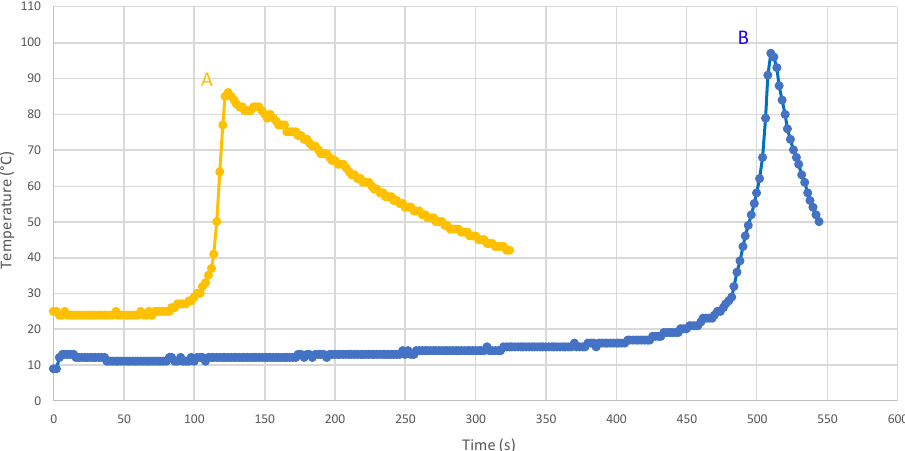
Figure 8. Optical pyrometric measurements (temperature vs. time after mixing; 4 mm thick sample) under air for the BM resin for Redox FRP using a T4epa/Iod (1.5%/1% w/w ) RIS at different temperatures: ( A ) @RT (23 °C); ( B ) @10 °C.